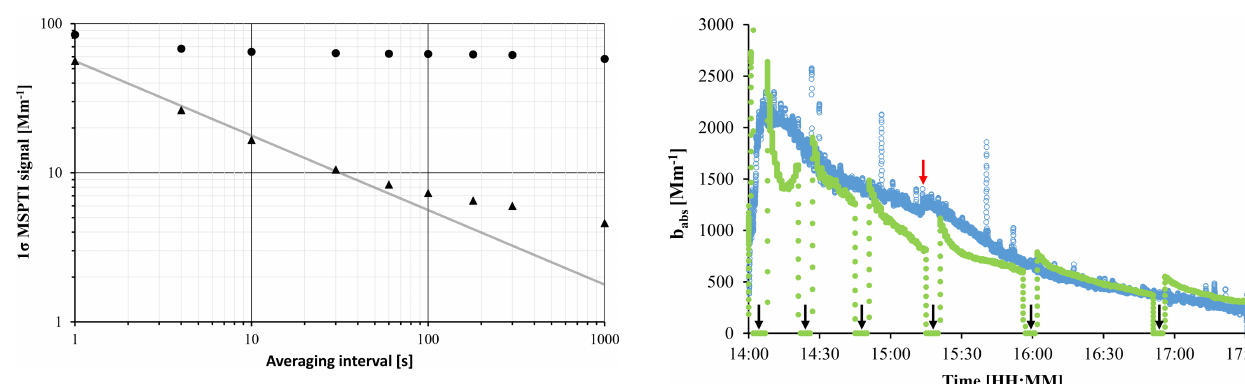
Figure 11. The SD of the baseline for drift-uncorrected (filled cir- cles) and drift-corrected data (filled triangles). The drift-corrected data approximately follow a square root dependence (grey line) on the averaging interval up to an averaging interval of 60s. Note the logarithmic scales. Table 1. Limits of detection for the MSPTI for different integra- tion times. Measured phase shifts were converted into absorption coefficients using the conversion factor from the NO 2 calibration presented in Fig. 9. The eBC concentration was calculated with a MAC value of 10m 2 g − 1 . This is lower than the value of 12m 2 g − 1 obtained by transferring the measurements of ambient BC particles by Zanatta et al. (2016) to 532nm using an Angström exponent of 1. Electrical-discharge-generated BC has been shown to have a MAC value lower than that of ambient soot (Schnaiter et al., 2003). As the MAC of the BC from the employed BC generator has not been measured directly, the limits of detection for eBC should be taken as a reference only. Note: ppb – parts per billion.